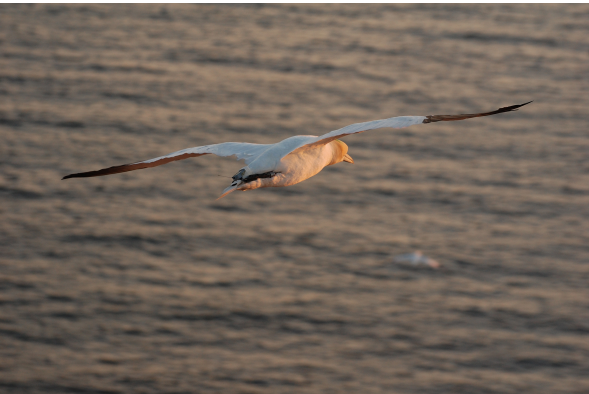
Figure 2. Flying northern gannets with a Bird Solar GPS logger attached to the tail feathers. Photo: K.